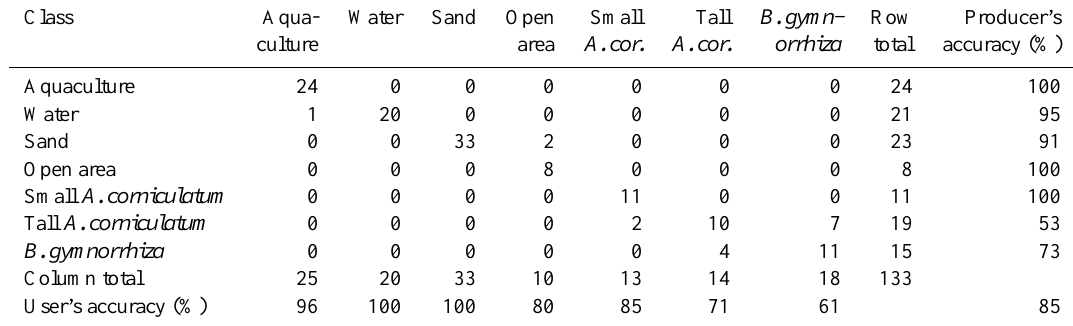
Table 3. Confusion matrix showing accuracy assessment of the supervised land-use/cover classification for Gaoqiao, China. Class